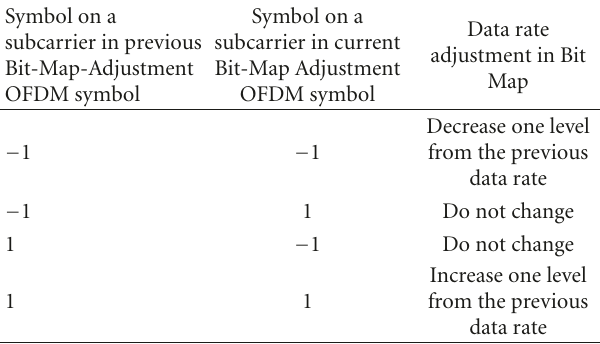
Table 1: Data rate adjustment on each subcarrier according to symbols assigned in bit-map-adjustment ofdm